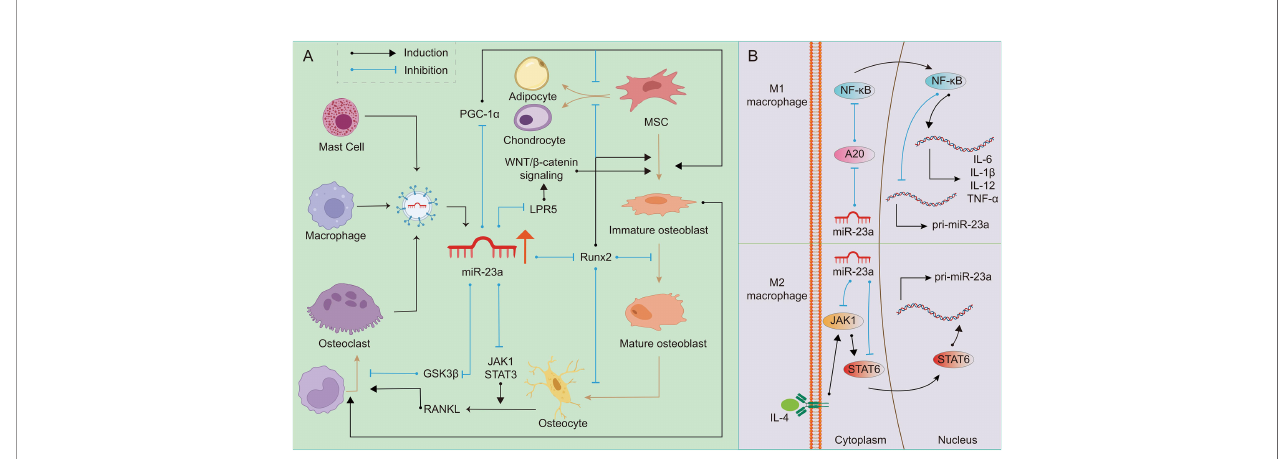
FIGURE 2 | Regulation of miR-23a on OB-OC-M F axis. A high level of miR-23a impairs the balance of the OB-OC-M F axis, leading to the occurrence of osteoporosis. (A) Many kinds of cells can secrete exosomes or extracellular vesicles containing miR-23a. On the one hand, miR-23a can target Runx2, LPR5 and PGC1 to regulate osteoblast differentiation and maturation; On the other hand, it can target GSK3 b and JAK1/STAT3 to regulate osteoclast differentiation. The regulation of miR-23a on osteoblasts can also indirectly affect the formation of osteoclasts. (B) In M1 macrophages, miR-23a speci fi cally inhibits A20, eventually reducing its own expression and promoting the expression of pro-in fl ammatory factors such as IL-1 b , IL-6, IL12 and TNF- a , which promote M1 macrophage polarization and bone resorption. MiR-23a targeted JAK1 and STAT6, and then inhibits the polarization of M2